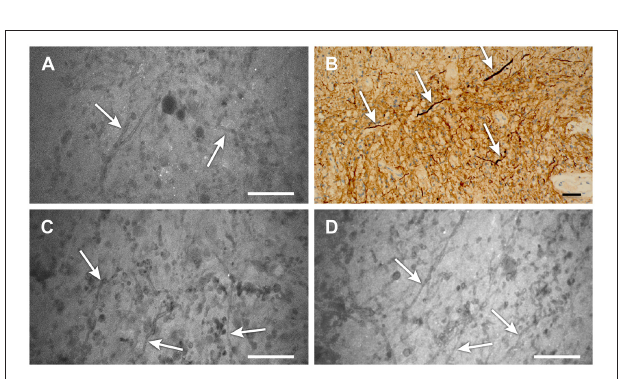
FIGURE 2 | Intraoperative tumor visualization. Exposure during tumor resection with (A) Yellow 560 filter and (B) standard white light. (C) Photograph of intraoperative frozen-tissue section slide interpreted as grade II glioma. (D) Confocal laser endomicroscopy (CLE) image showing subtle discrete cellular aggregates ( arrows ) within a relatively widespread area of cells interpreted as consistent with lower-grade glioma 1.5h after injection of 40 mg/kg fluorescein sodium (FNa). (E) A vessel 1.5h after injection of 40 mg/kg FNa showing irregular endothelium ( top arrow ), with a focus of cells indicating pleomorphism relative to surrounding cells ( center arrow ) and what appears to be a mitotic figure ( bottom arrow ). (F) Scanning electron microscopy (SEM) image showing glioma cell morphology with multiple small vesicles and protrusions. (G) CLE image of another tumor area demonstrates small bright dots that likely represent cell surface vesicles with fluorescein, which corresponds well to the SEM microscopy of the cells. These bright dots were visible throughout the tumor on CLE images. Scale 50 µ m (D,E,G) . Panels (A–E,G) are used with permission from Barrow Neurological Institute, Phoenix, Arizona. Panel (F) is